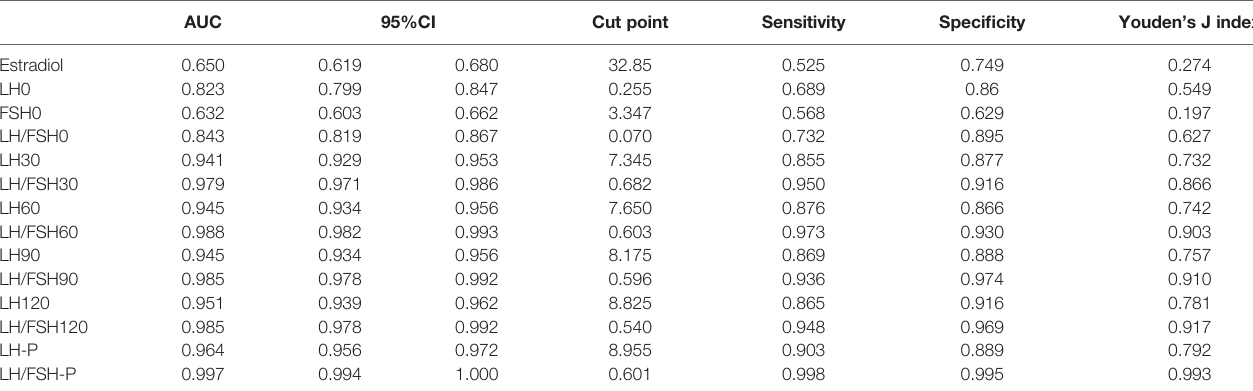
TABLE 2 | Gonadotropin cut point for best discriminating pubertal status from ROC curves. AUC 95%CI Cut point Sensitivity Speci fi city Youden ’ s J index Estradiol